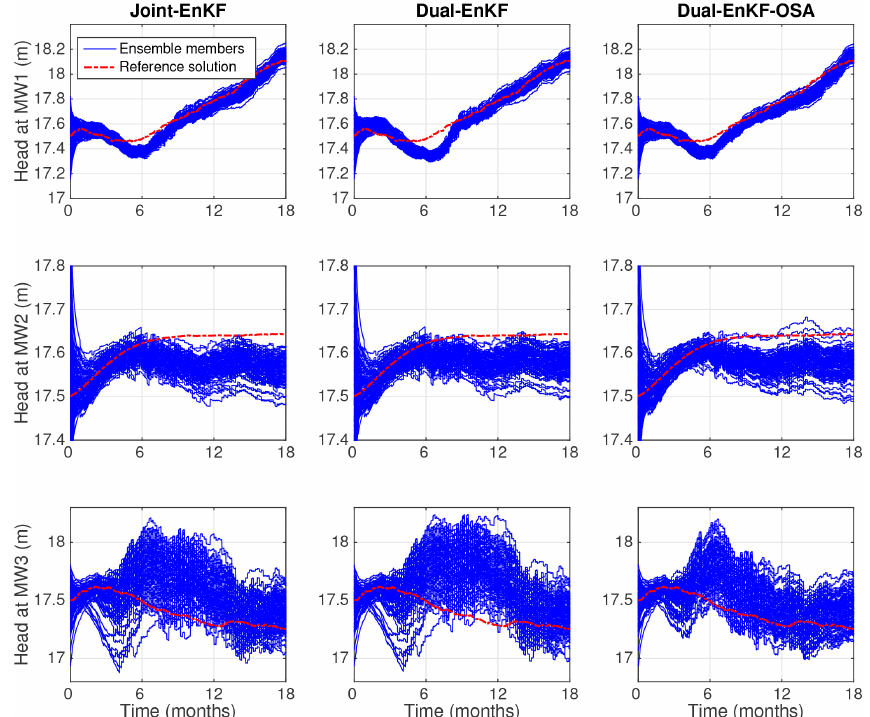
Figure 6. Reference (dashed) and predicted (solid) hydraulic head evolution at monitoring wells MW1, MW2, and MW3. Results are obtained using the joint EnKF and the dual EnKF OSA schemes with 100 members, 5 days as sampling period, nine observation wells, and 0.10m of measurement noise.